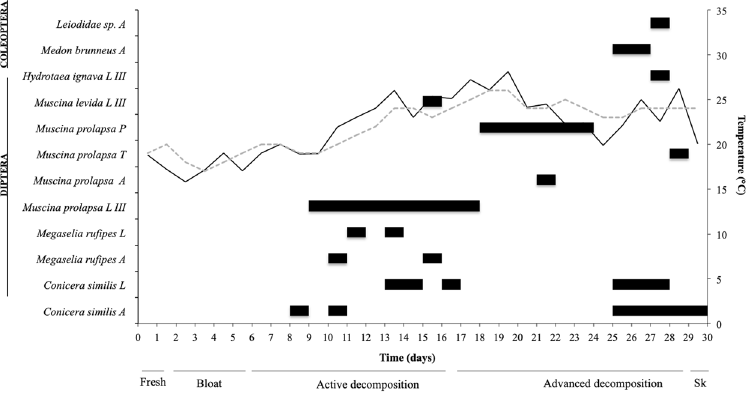
Figure 4. Diptera (black) and Coleoptera (grey) colonization pattern on rat carcasses, during June experimental period. Surrounding soil (grey dashed line) and air (black line) temperature variations and decomposition stages were indicated for the concerned period; A – adult; L – larvae; LIII – third instar larvae; P – pupae; T – teneral